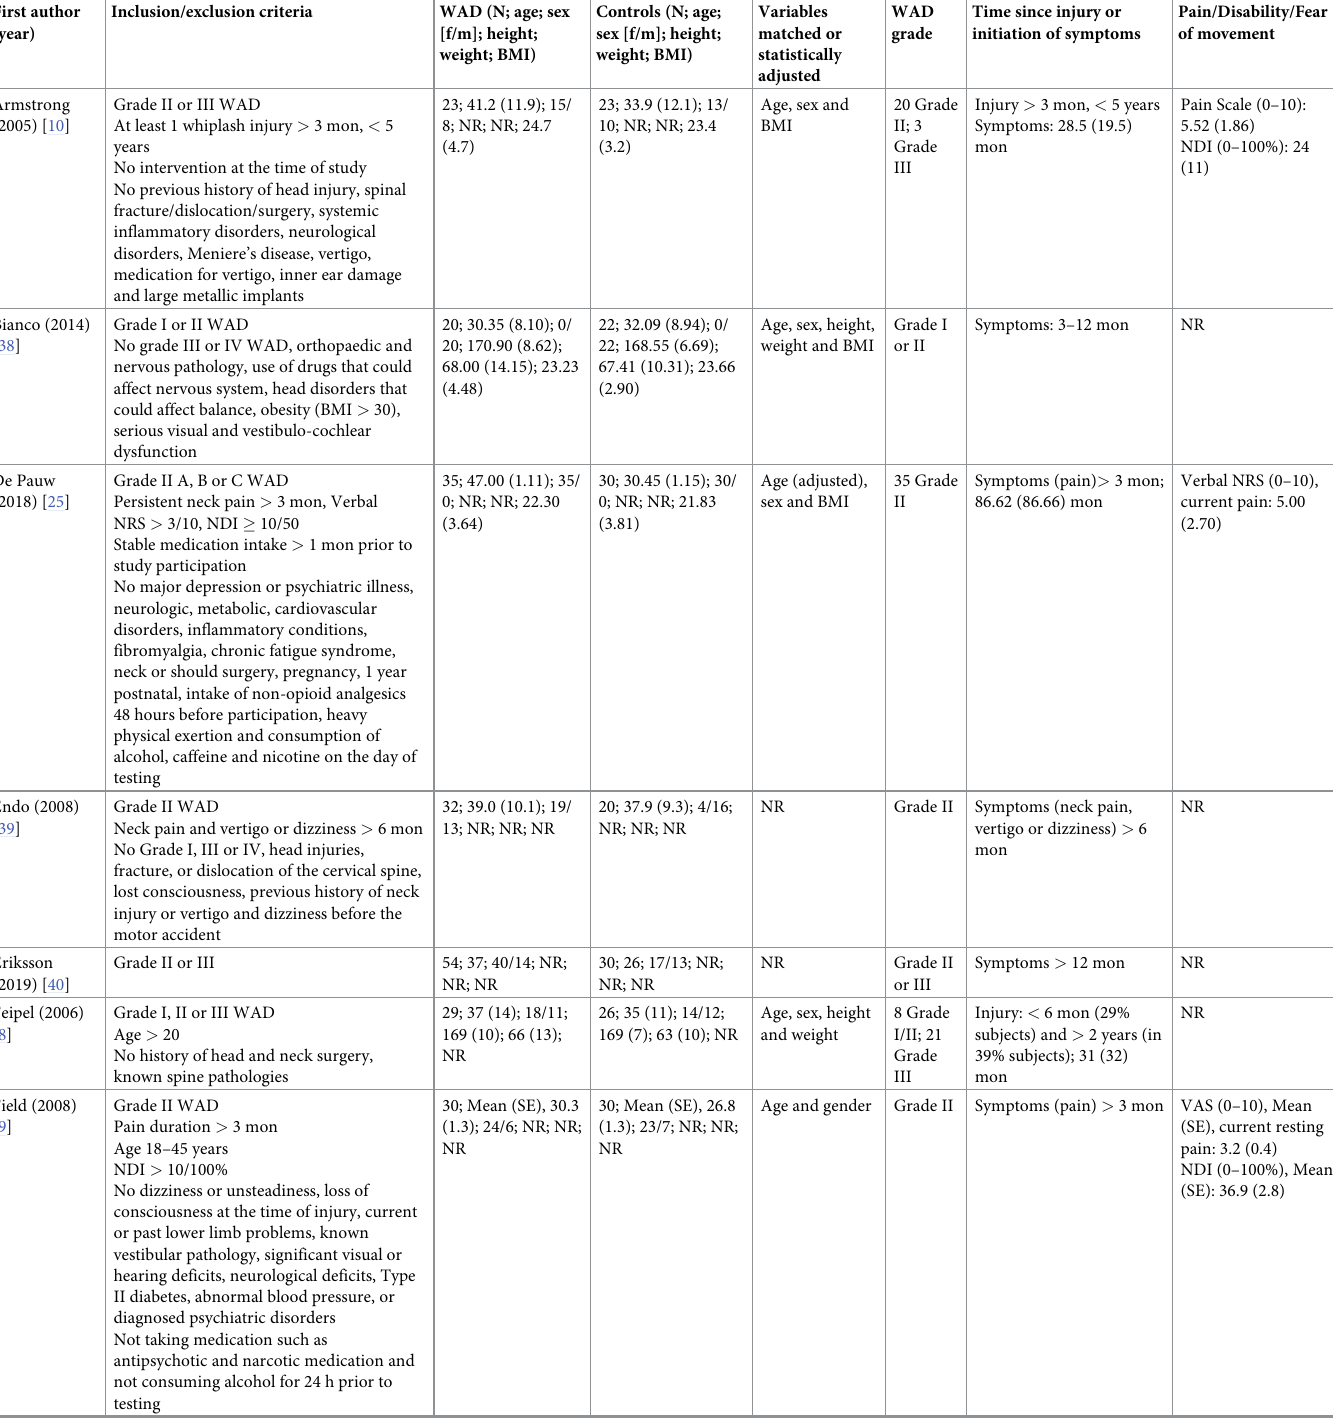
Table 3. Inclusion/Exclusion criteria and demographic characteristics of all included